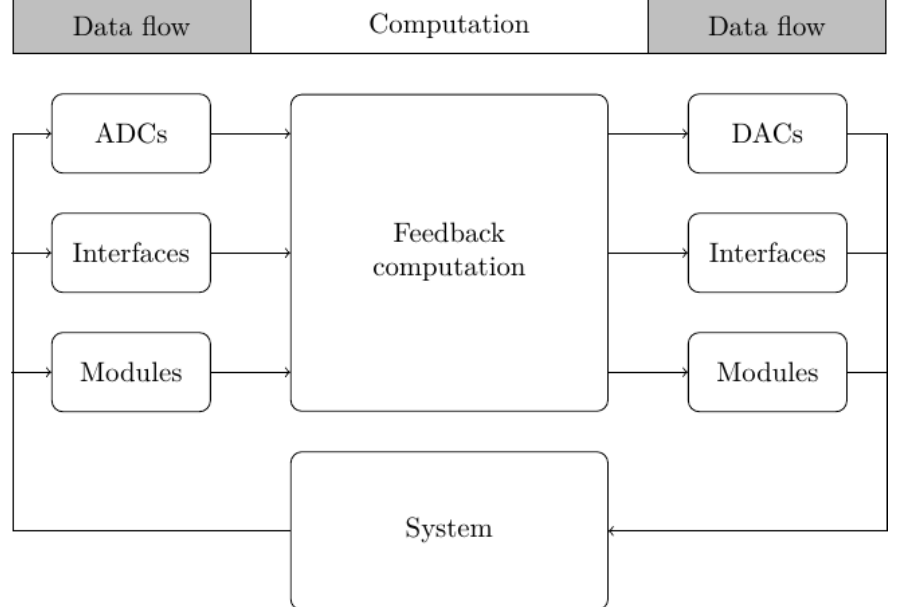
Figure 1. An outline of the software components in a typical real-time system that performs feedback control. Input data come from analog to digital (ADC) converters that read sensor inputs, network interfaces (when the system is distributed among different computers in a local area network (LAN)) or other software modules that perform input data pre-elaboration. Output data are directly sent to digital to analog (DAC) converters in order to drive actuators, network interfaces (when the actuators are on a different system) or other software modules for post-processing